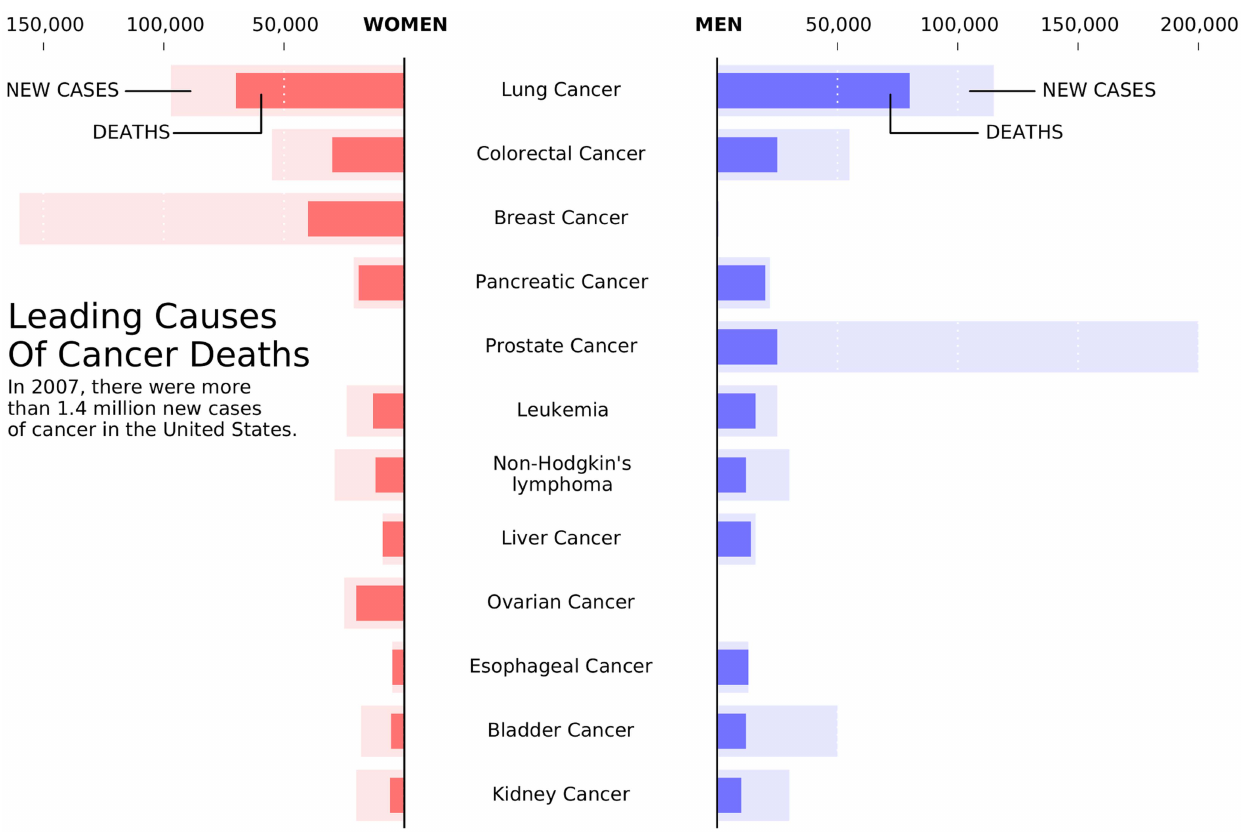
Figure 1. Know your audience. This is a remake of a figure that was originally published in the New York Times (NYT) in 2007. This new figure was made with matplotlib using approximated data. The data is made of four series (men deaths/cases, women deaths/cases) that could have been displayed using classical double column (deaths/cases) bar plots. However, the layout used here is better for the intended audience. It exploits the fact that the number of new cases is always greater than the corresponding number of deaths to mix the two values. It also takes advantage of the reading direction (English [left-to-right] for NYT) in order to ease comparison between men and women while the central labels give an immediate access to the main message of the figure (cancer). This is a self-contained figure that delivers a clear message on cancer deaths. However, it is not precise. The chosen layout makes it actually difficult to estimate the number of kidney cancer deaths because of its bottom position and the location of the labelled ticks at the top. While this is acceptable for a general-audience publication, it would not be acceptable in a scientific publication if actual numerical values were not given elsewhere in the article.